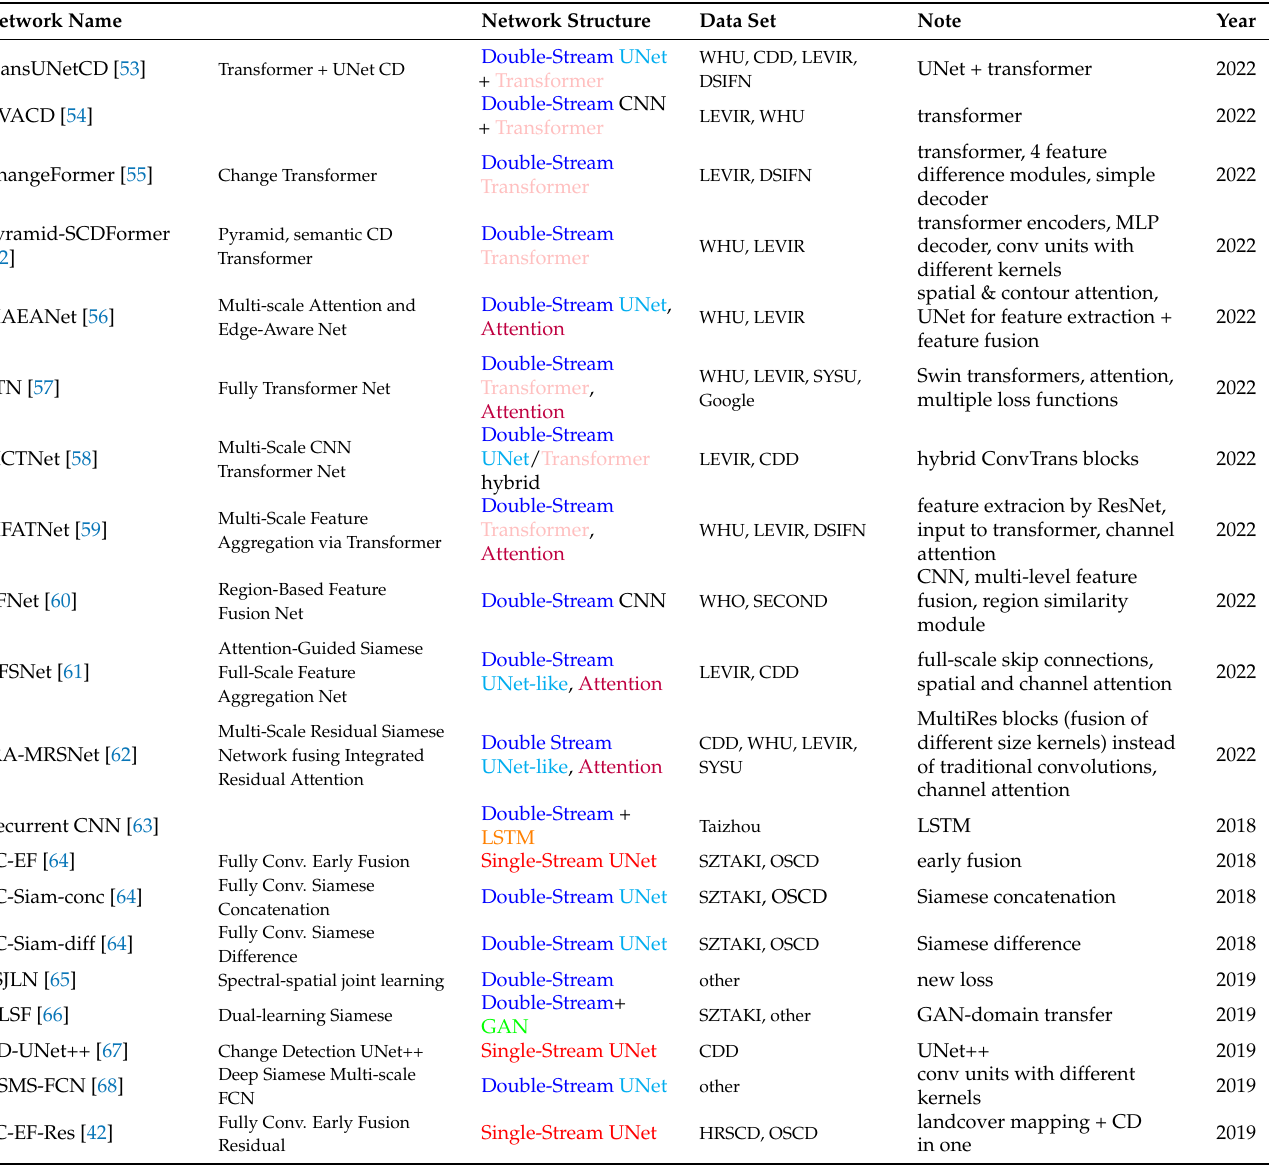
Table 2. Overview of selected supervised change-detection models published between 2018 and 2022, listed